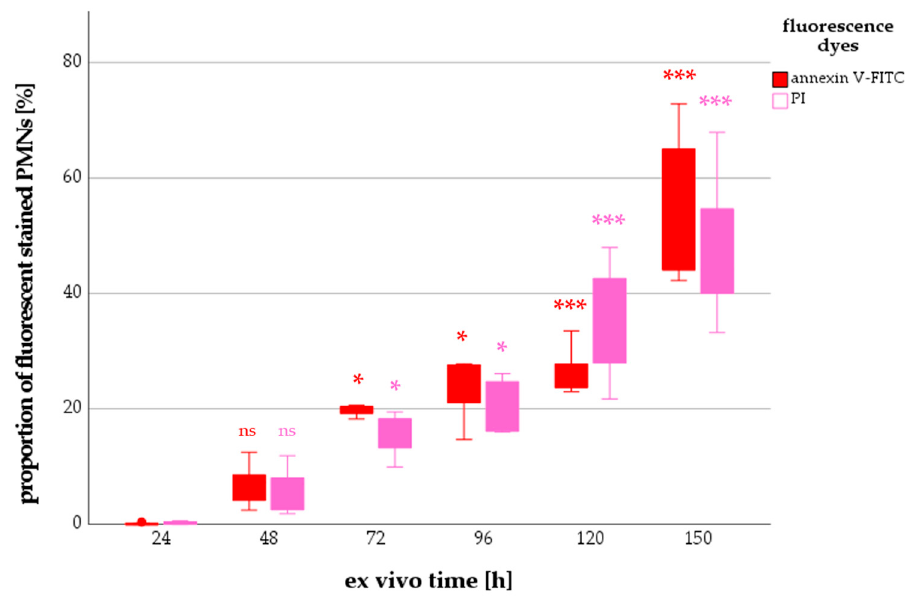
Figure 4. Number of non-surviving PMNs with increasing ex vivo time. Signi fi cant di ff erences be- tween groups compared with an ex vivo time of 24 h are red or pink colored (ns = not signi fi cant; * p < 0.05; *** p < 0.001).